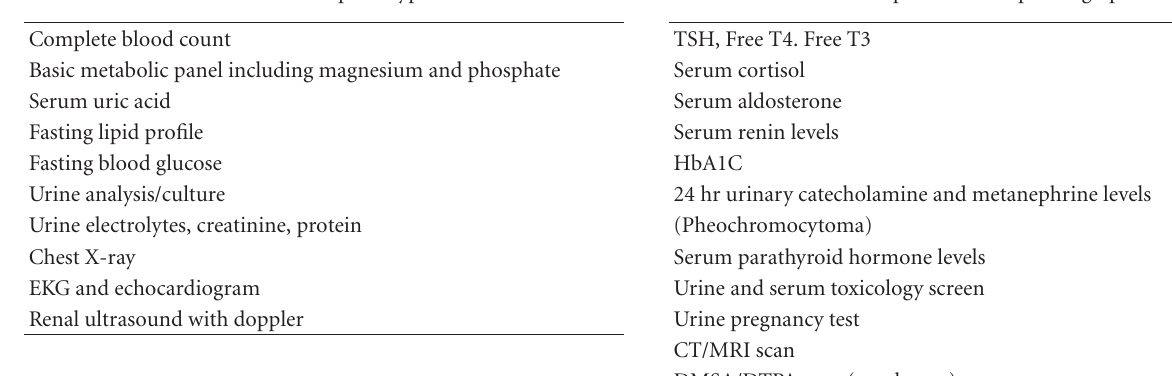
Table 5: Initial workup for hypertension. Table 6: Further workup if needed depending upon the